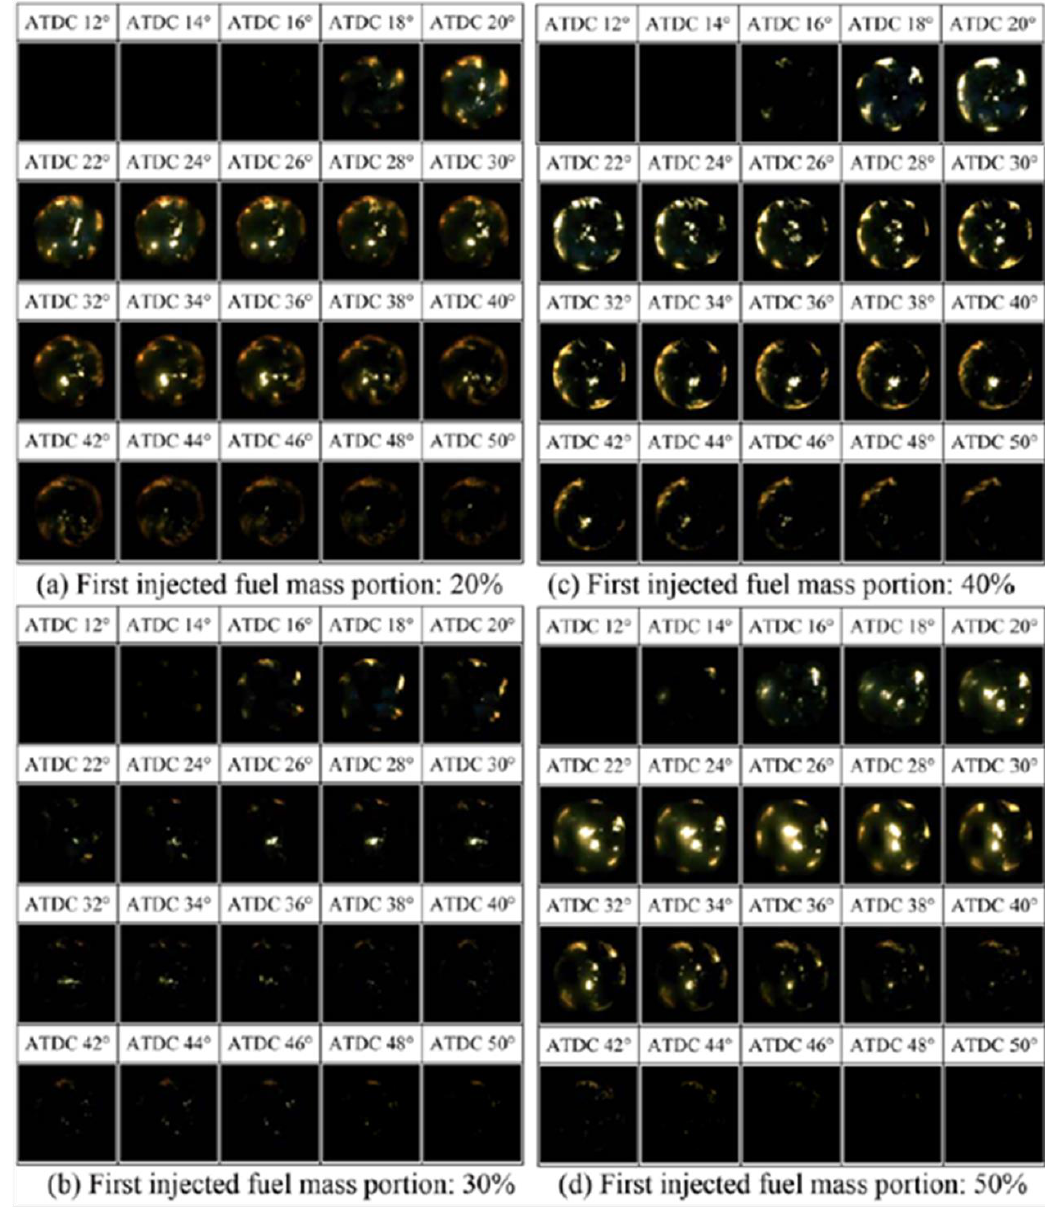
Figure 10. Flame characteristics as a function of the first injection quality ratio [79]. ( a – d ): first injected fuel mass portion: 20%, 30%, 40%, and 50%, respectively; the images of flame change with crank angle.